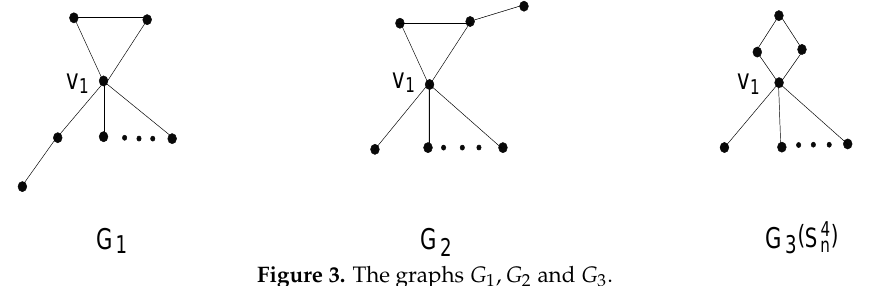
Figure 3. The graphs G 1 , G 2 and G 3